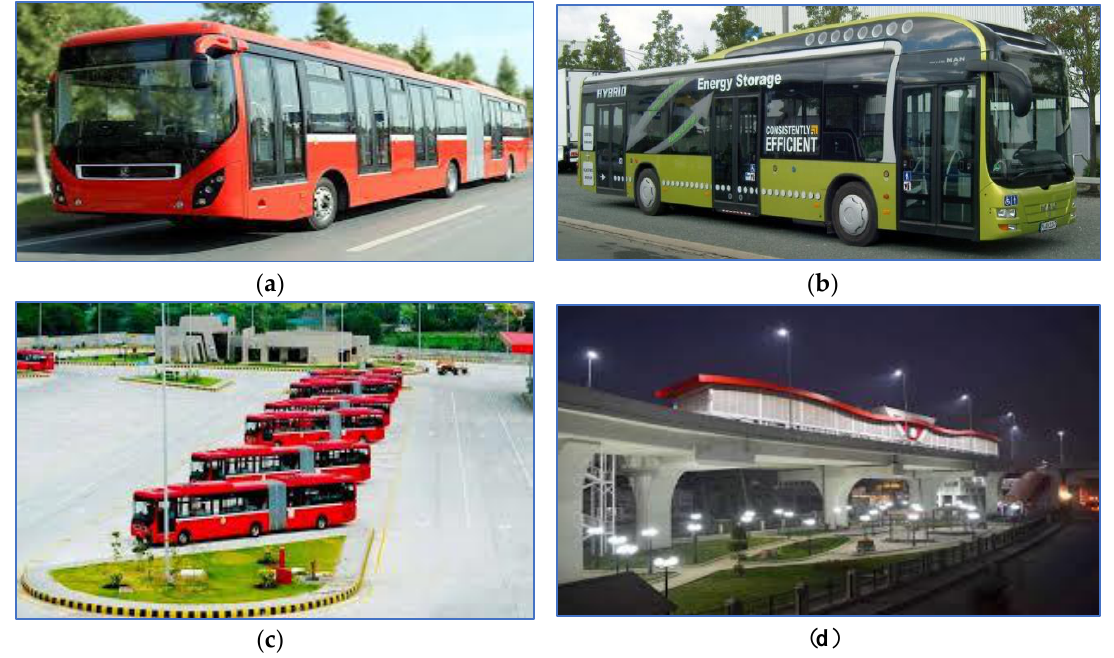
Figure 4. The BRT-Metro Bus System: ( a ) Diesel Fuel Bus, ( b ) Hybrid Battery Base Bus, ( c ) Service Area, and ( d ) Station